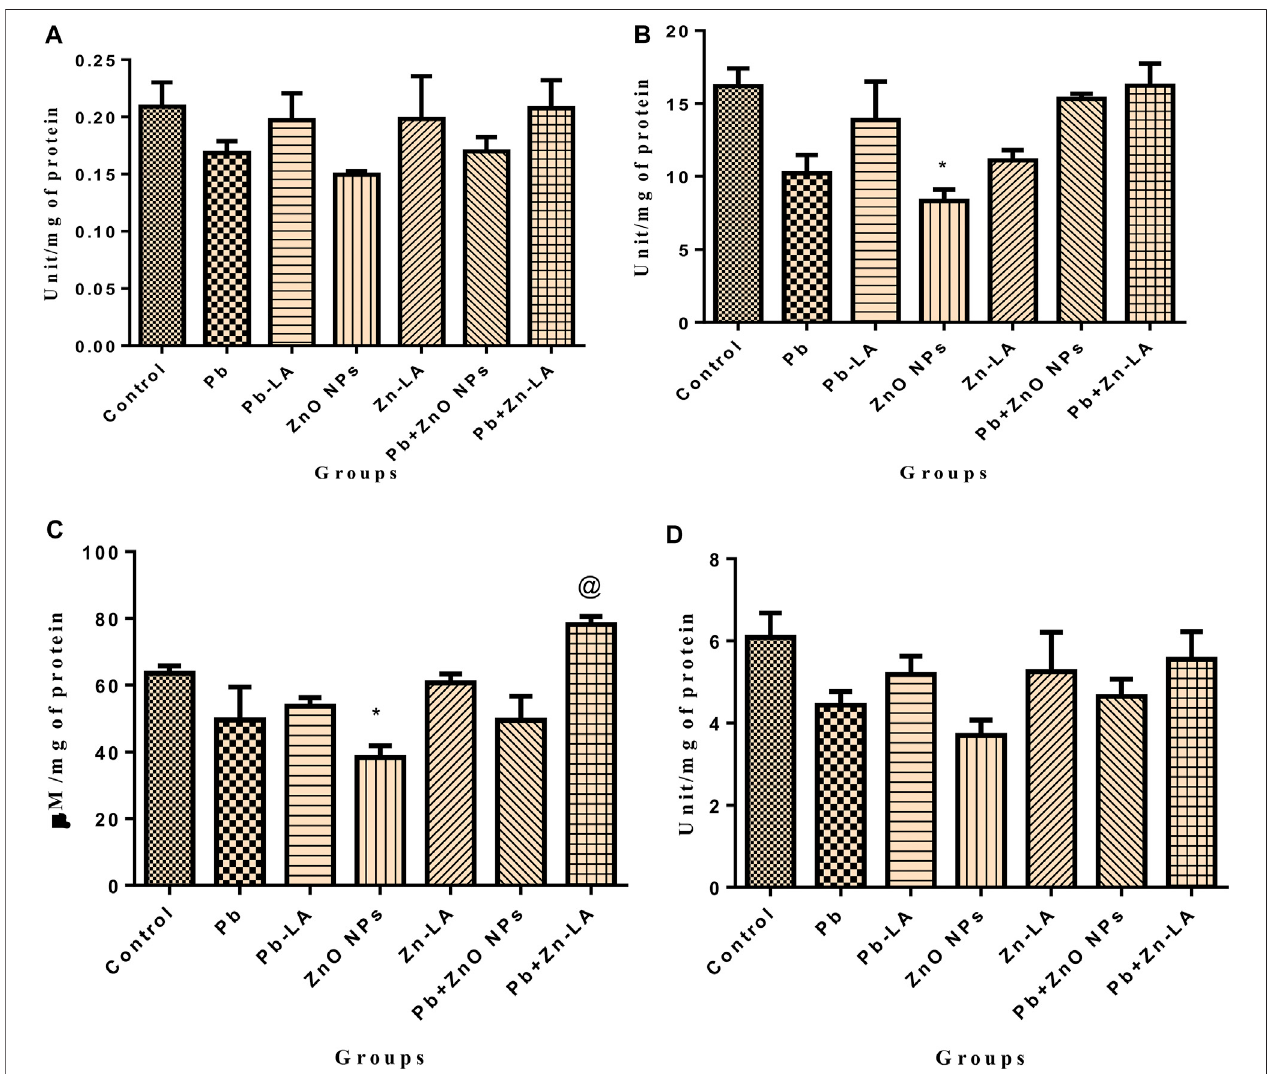
FIGURE 10 | Testes biochemical parameters. (A) SOD, (B) catalase, (C) GSH, and (D) GPx. The data are presented as mean ± SEM. Statistical signi fi cance is represented as * p < 0.05, as compared to the control group and @ p < 0.05, as compared to the combination group.